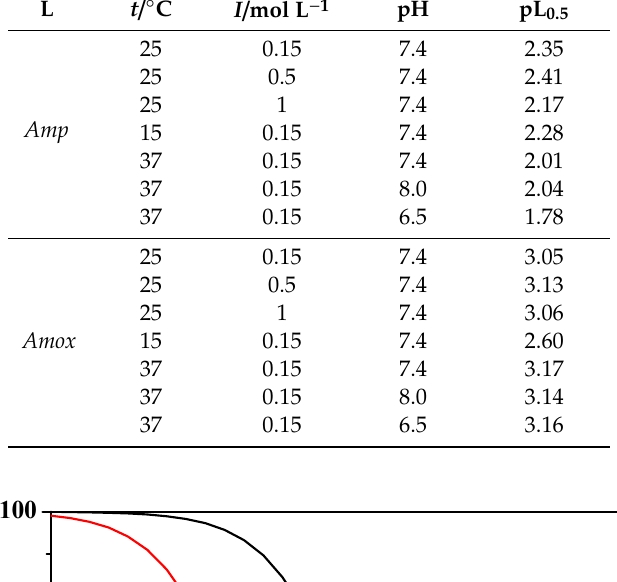
Table 5. pL 0.5 values of Amp and Amox towards Mn 2+ at different pH, ionic strengths and temperatures.